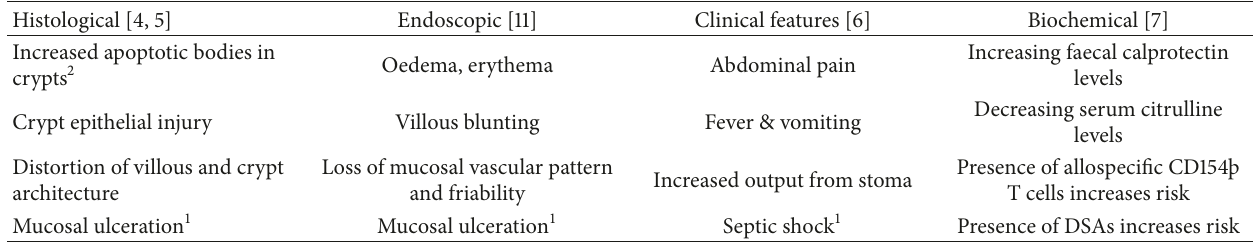
Table 1: Diagnostic features of acute cellular intestinal allograft